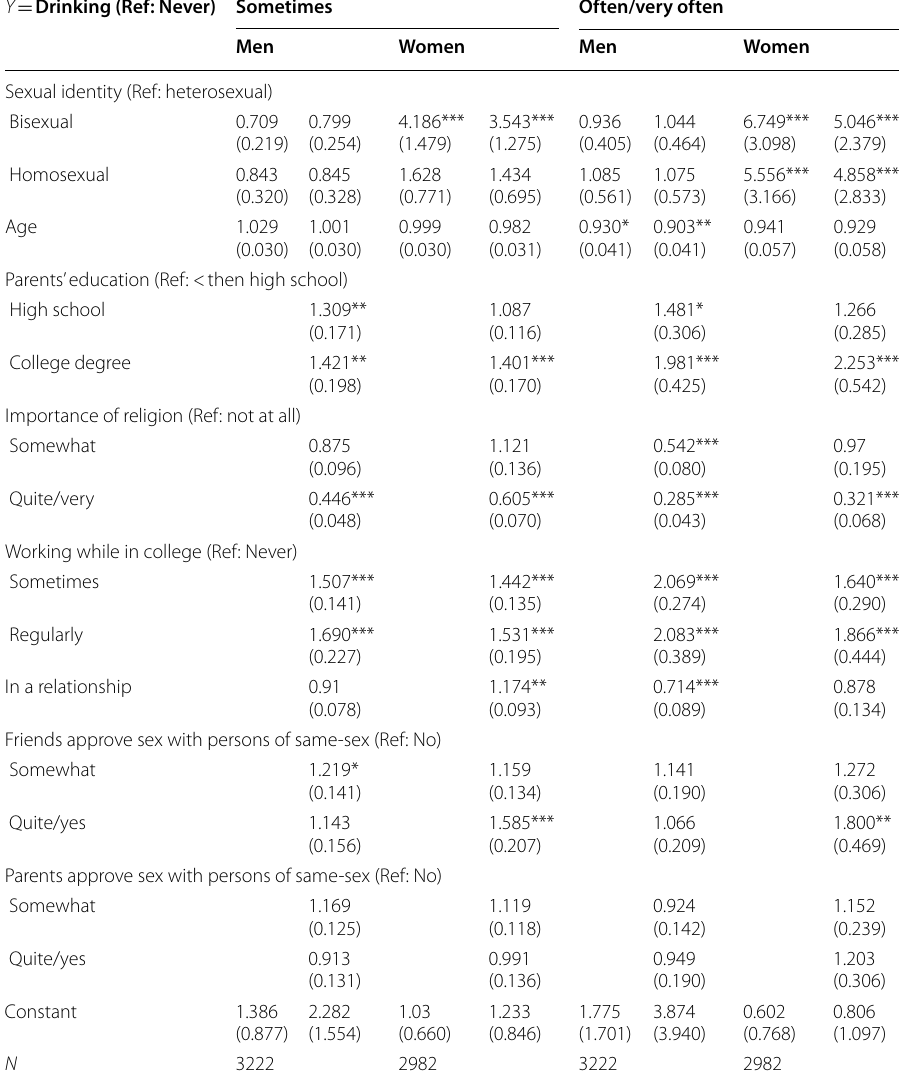
Table 3 Multinomial logistic regression,